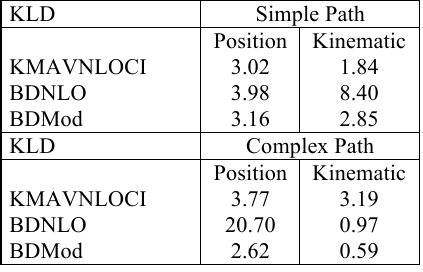
Table 1. Kulback Leibler Divergence